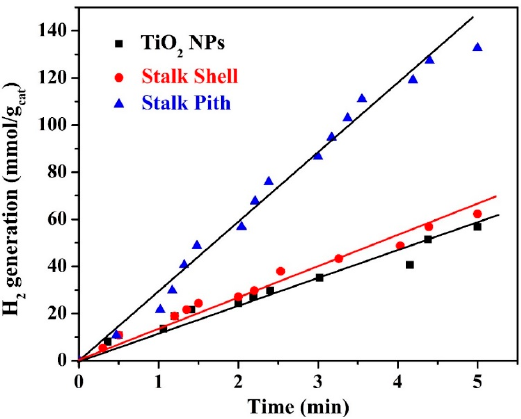
Figure 10. Hydrogen production rate from water splitting under visible light radiation using a cat- alyst produced from the shell and bulb of the corn stover. The photocatalytic performance is com- pared with that of TiO 2 NPs